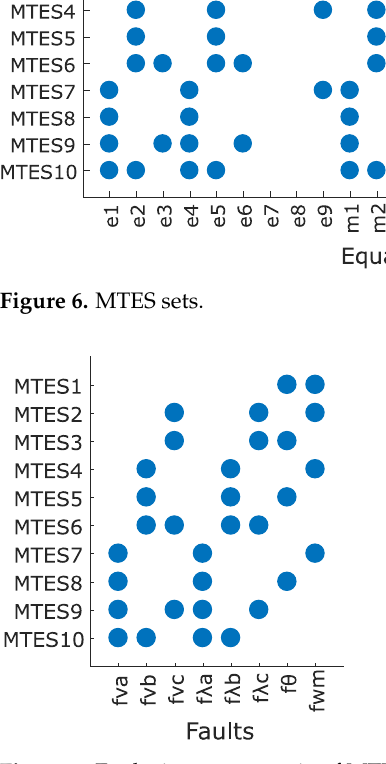
Figure 7. Fault signature matrix of MTES